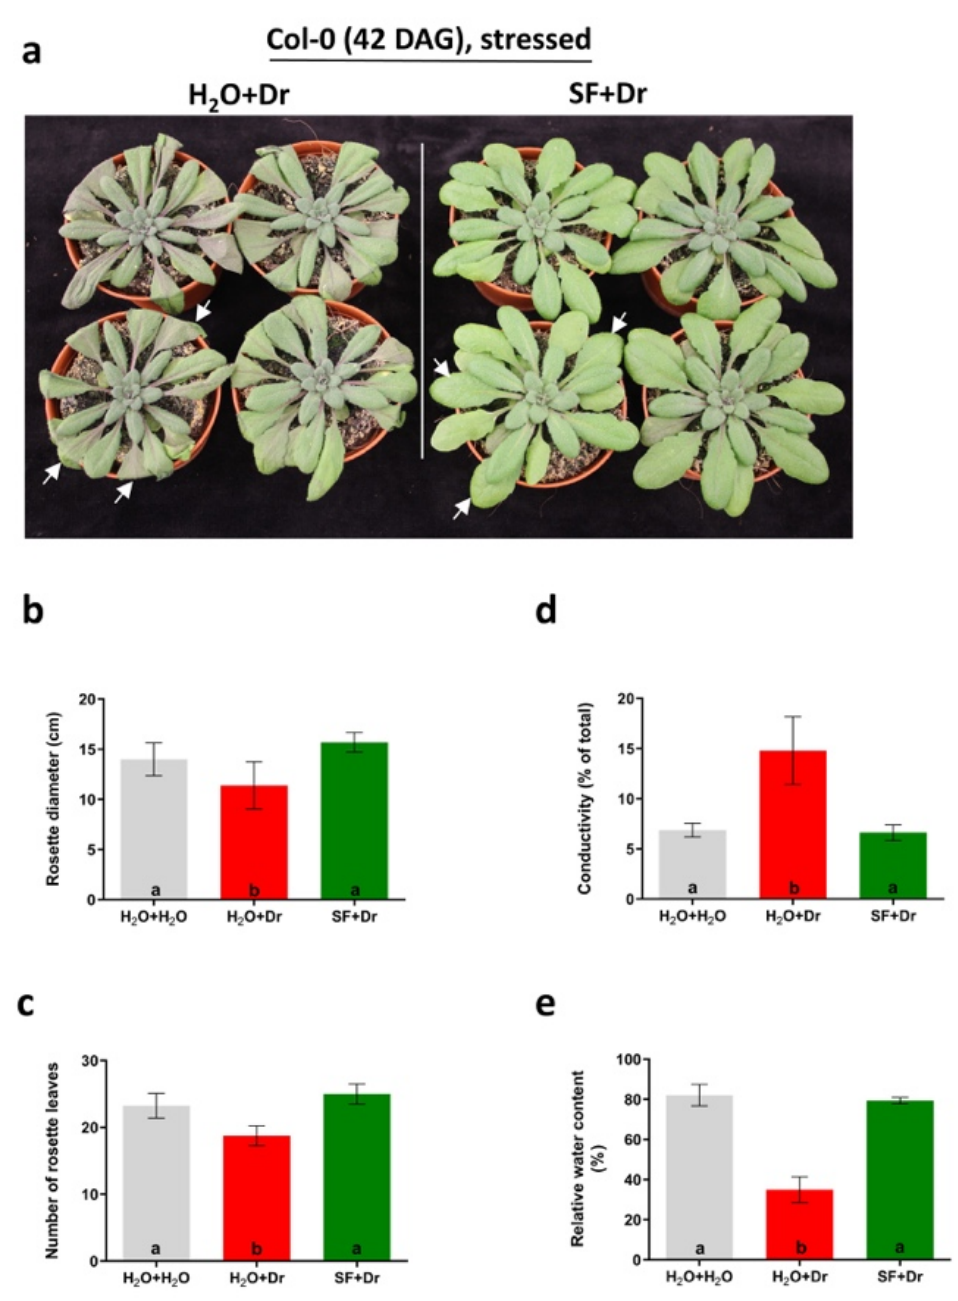
Figure 1. Response of Super Fifty (SF)-primed and unprimed plants to drought stress. ( a ) Arabidopsis plants after 11 days of drought stress, at 42 days after germination (DAG). In the absence of SF priming, drought-stressed plants (H 2 O+drought stress (Dr)) show stress-related symptoms (wilting of most leaves), while drought stress-related symptoms are seemingly absent in SF-primed plants (SF+Dr). Leaves no. 8, 9, and 10, harvested for ion conductivity and relative water content (RWC) measurements—see panels ( d , e )—are indicated by white arrows (representative images). ( b ) Rosette diameter. ( c ) Number of rosette leaves. Data in ( b , c ) were obtained for plants at 40 DAG. ( d ) Ion conductivity in leaves as a measure of membrane damage. ( e ) Relative water content in leaves. Error bars denote the standard deviation of the mean (SD). Treatments sharing same letters indicate nonsignificant differences, while treatments with different letters indicate significant differences ( p < 0.05; one-way ANOVA, Tukey’s multiple comparison test). Dr, drought stress; SF, Super Fifty. 2.2. SF Priming Lowers Hydrogen Peroxide Levels in Plants Hydrogen peroxide (H 2 O 2 ) is an important stress molecule that accumulates to often toxic levels in many abiotic stresses including drought [26,27], while moderate levels of H 2 O 2 have a signaling function in plants [28,29]. Avoiding high levels of H 2 O 2 is, thus, important to keep plants healthy and for maintaining growth. Having observed the ben- eficial effect of SF on drought-stressed plants, we considered that SF priming might affect H 2 O 2 levels. Therefore, H 2 O 2 levels were determined by 3,3’-diaminobenzidine (DAB) staining in young Arabidopsis leaves (first leaf pair) from 15-day-old plants. In the ab- sence of drought, SF-treated leaves showed weaker DAB staining than non-SF-treated plants, indicating lower H 2 O 2 accumulation (Figure 2a). This observation was confirmed by Amplex Red assay (Figure 2b). Furthermore, H 2 O 2 levels were determined in rosettes of Arabidopsis plants subjected to drought stress in the absence or presence of SF treat- ment. While in the absence of SF priming H 2 O 2 levels strongly increased in drought- stressed plants, this increase was significantly reduced in SF-treated plants (Figure 2c).